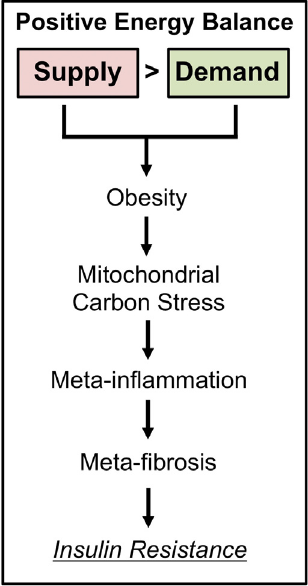
Figure 1. Positive energy balance promotes insulin resistance via metabolism-driven inflammation and fibrosis. Energy balance is defined as the difference between absorbed dietary macronutrients (Supply) and energy expenditure (Demand). Energy supply is determined by the quantity and composition of macronutrients consumed, whereas energy demand is determined by exercise, non-exercise activity thermogenesis, and resting metabolic rate. A net positive energy balance (Supply > Demand) leads to obesity and a cascade of events that includes mitochondrial carbon stress (that is, an oversupply of macronutrients to mitochondria). This metabolic stress on mitochondria can promote meta-inflammation and meta-fibrosis that ultimately contribute to cellular and systemic insulin